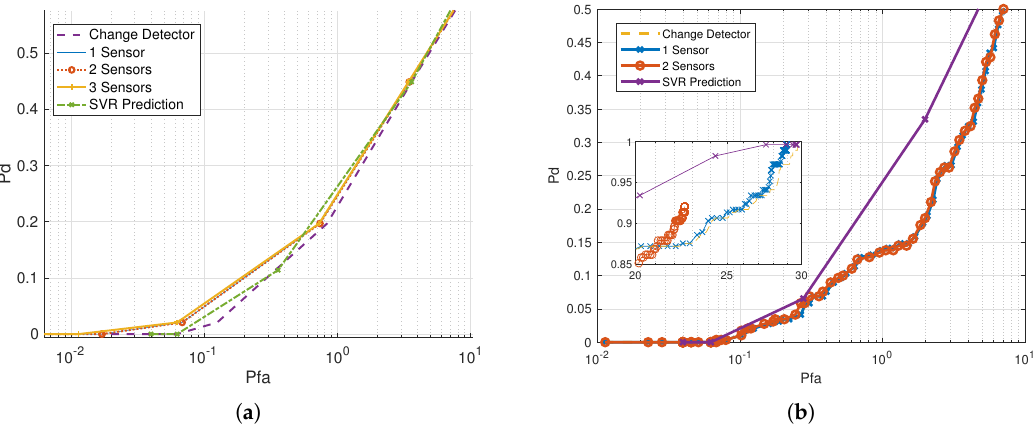
Figure 8. Receiver operating characteristics (ROC) results shown for standard anomaly detection (change detector) and for cross-sensor validation—majority vote for anomaly agreement by 1, 2 and 3 datasets, and soft-analysis by support virtual regression (SVR). ( a ) A gradient test for raw data. ( b ) Spike test for wavelet transform over the